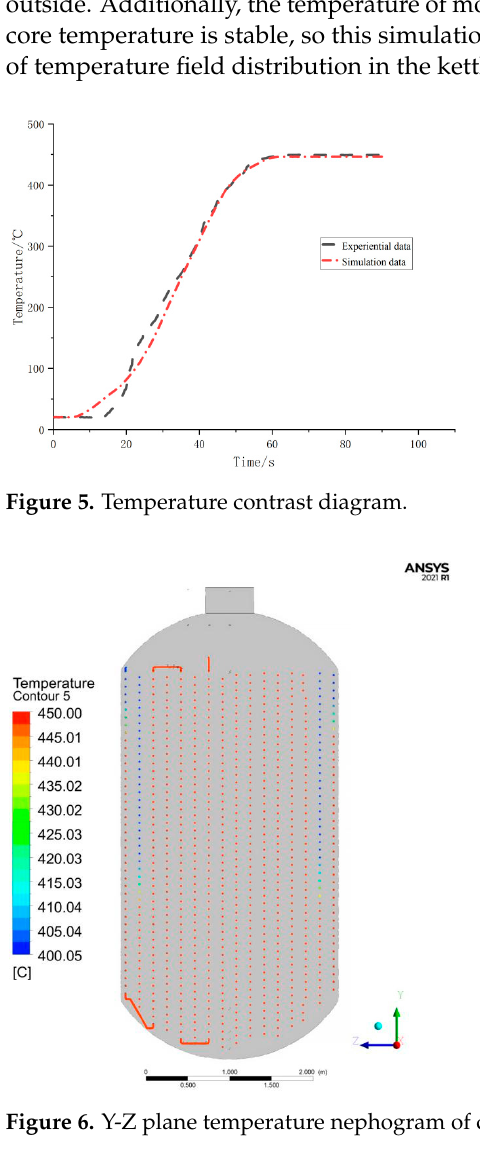
Table 2. Sensitivity analysis of grid size.